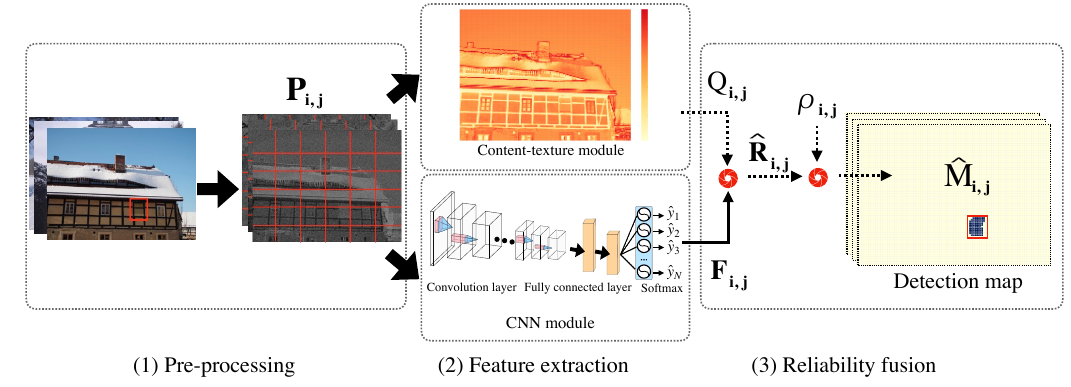
Figure 2. Flowchart of our proposed